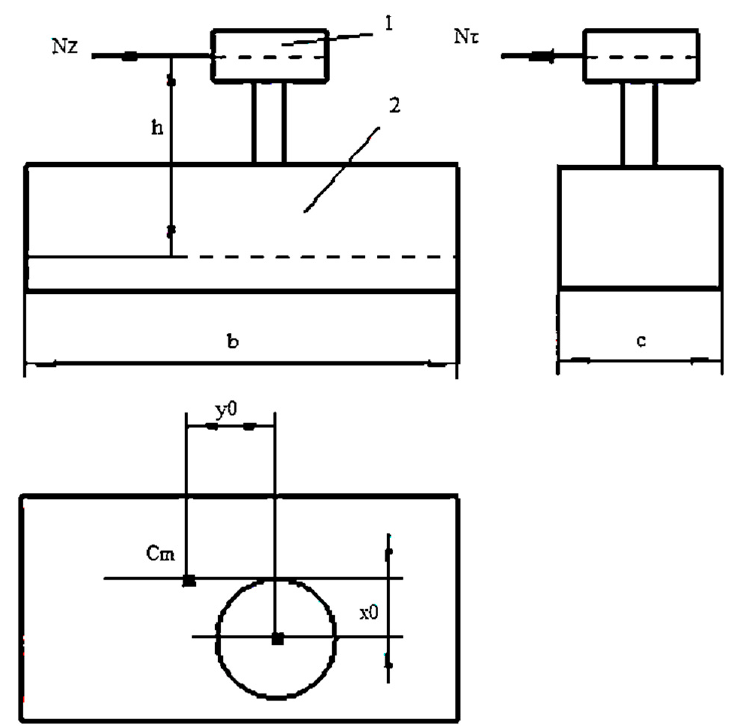
Figure 8. The active force of the bolt body. Note: 1—main roller, 2—bolt